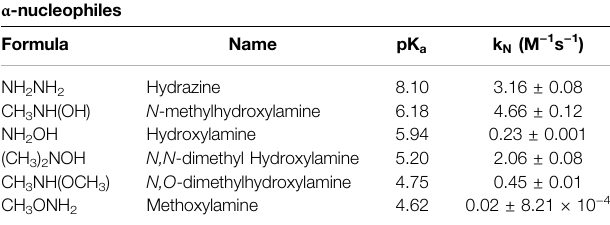
TABLE 1 | Summary of nucleophiles and their pK a values in water and k N values for the nucleophile series with 2-chloro-5-nitro pyrimidine. α